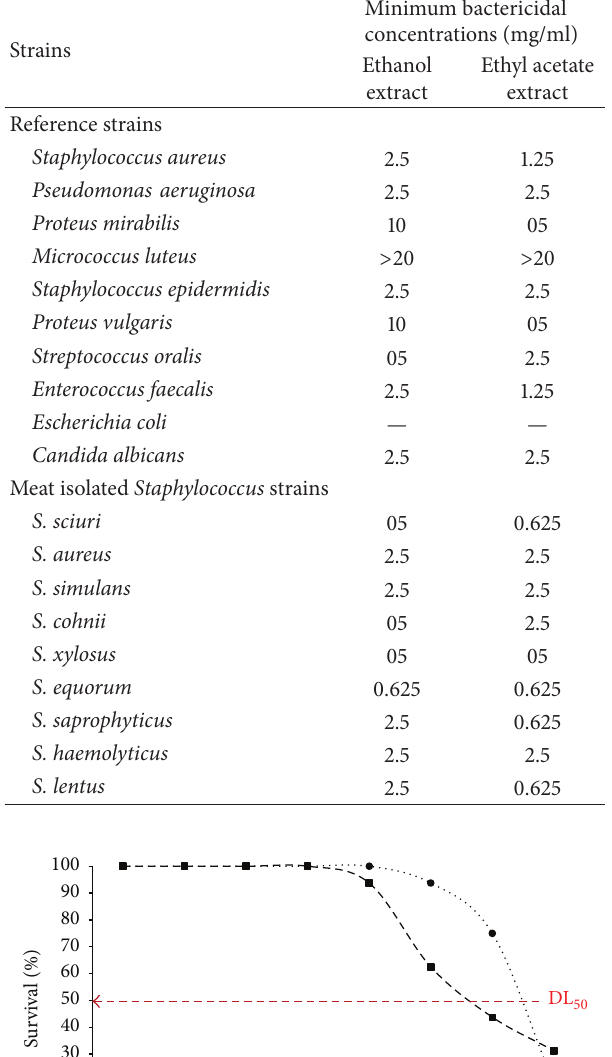
Table 3: Minimum inhibitory concentrations of C. nitida ’s bark extract on reference strains and meat isolated Staphylococcus strains.